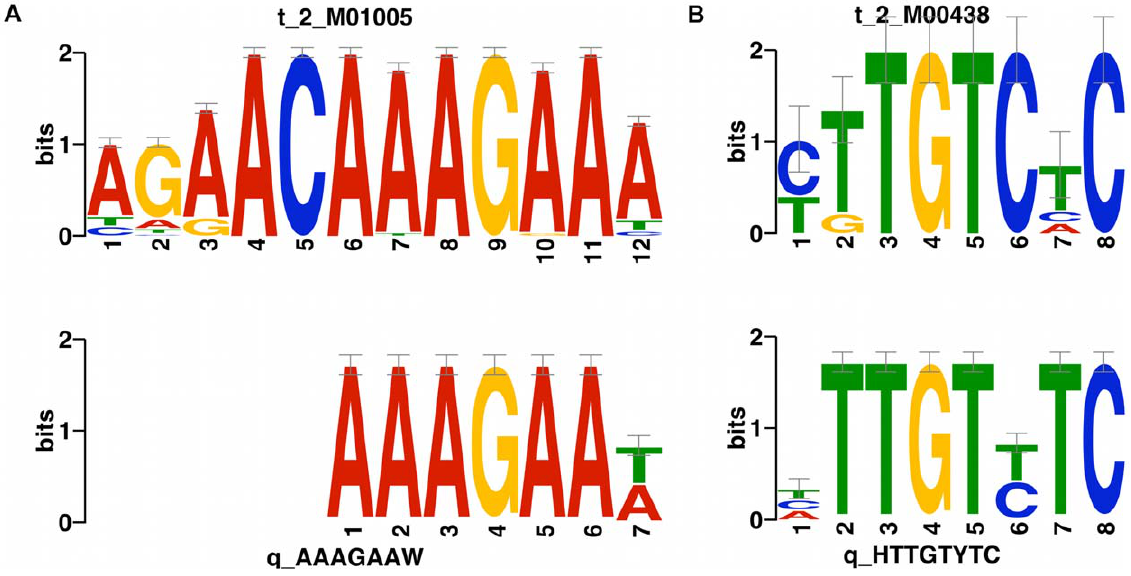
Figure 8. Two sequence motifs from intergenic ncRNAs with significant similarity against known DNA motifs. For each comparison, the upper one is the known DNA motif, and the lower one is the intergenic ncRNA sequence motif.